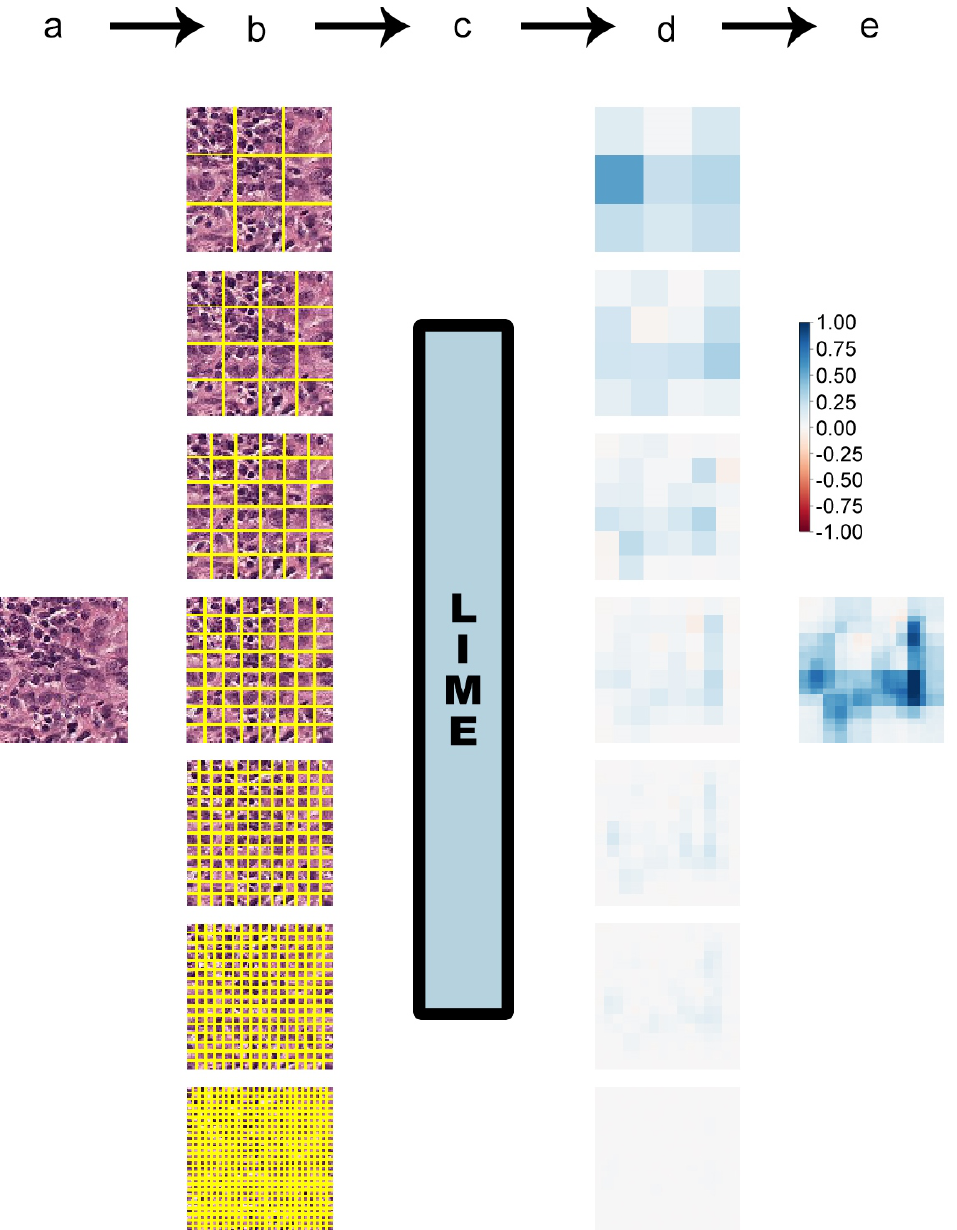
Figure 4. Diagram of the squaregrid method in four steps. The flowchart is identical to the previously-presented one, but instead of superpixels, the image was progressively divided into finer square grids. Seven grids were used, ranging from nine squares to 576. Explanation heat maps were generated for each of these grids, and a final heat map was computed as the sum of the seven previous heat